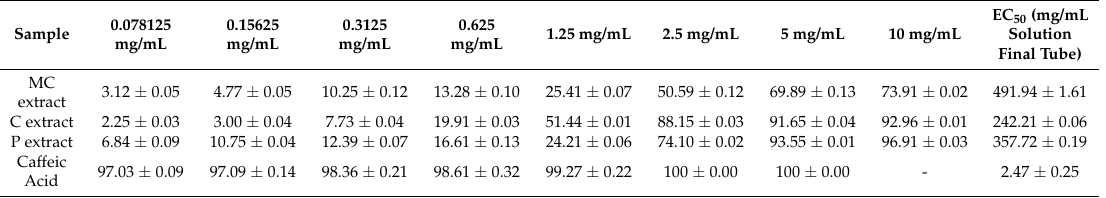
Table 4. Iron chelation potential of the selected